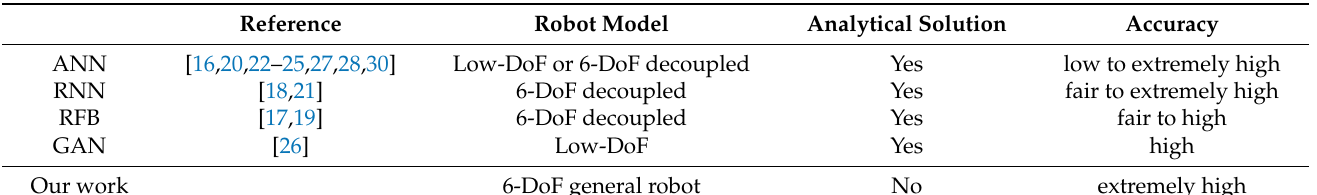
Table 1. Comparison of the previous and present